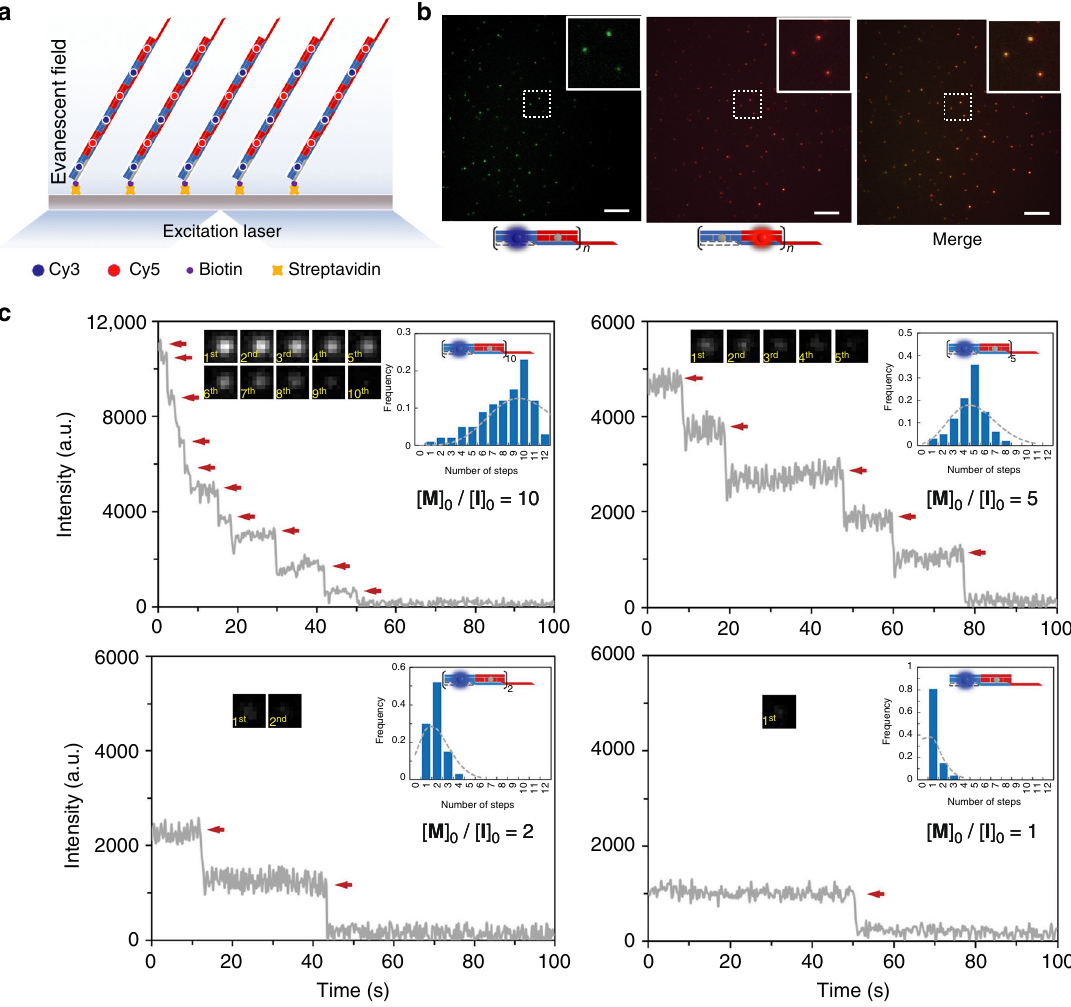
Fig. 3 Single-molecule fl uorescence imaging of copolymerization of 1D DH nano fi laments. a Schematic illustration of the fl uorophore-labeled nano fi laments (copolymerized at the ratio [ M ] 0 /[ I ] 0 = 2) imaged through total internal re fl ection fl uorescence microscopy (TIRFM). Cy3 (blue dot) and Cy5 (red dot) are labeled in the core strands a1 and b1 , respectively. b TIRFM images of surface-grafted nano fi laments acquired with the excitation of 561 nm (left) and 633 nm (middle). Overlay image (right) shows the colocalization of Cy3 (green) and Cy5 (red) labels. c Representative intensity vs time trajectories illustrating the fl uorescence photobleaching of Cy3-labeled nano fi laments copolymerized with ratios of [ M ] 0 /[ I ] 0 = 10, 5, 2, and 1, respectively (arrows indicate photobleaching